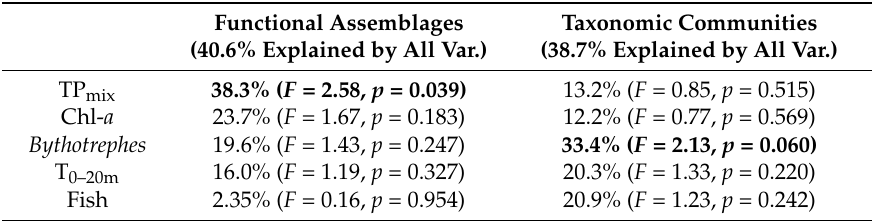
(40.6% Explained by All Var.)